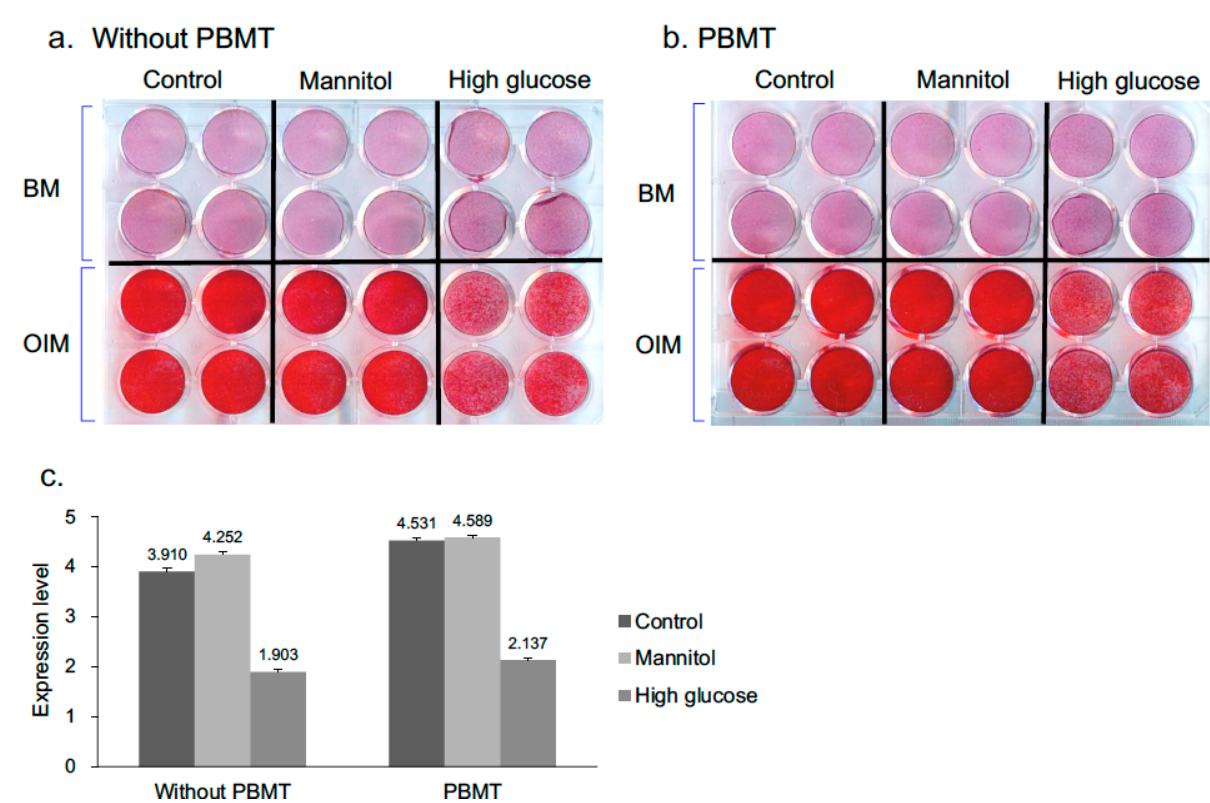
Figure 1. Analysis of the mineral deposition in D1 cells on day 7 by Alizarin Red S staining. ( a , b ) Representative photographs from Alizarin Red S staining assays. D1 cells were cultured in BM or OIM with low or high glucose content for 7 days. PBMT treatment (8 J/cm 2 ) was applied daily directly onto cells. Cells were stained with Alizarin Red S for mineralization analysis. ( c ) Quantitative data obtained from destained Alizarin red S absorbance. The results are expressed as means ± SD of three replicates.